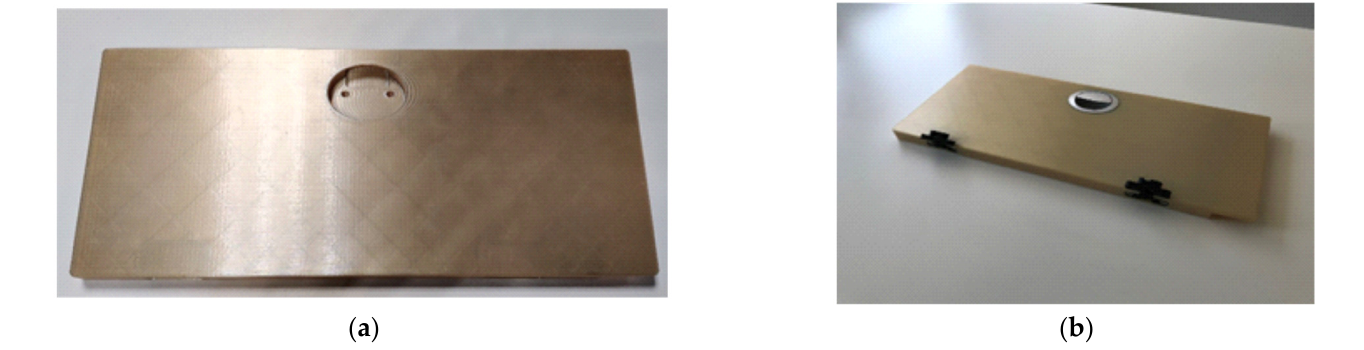
Figure 12. 3D-printed folding table from Ultem 9085 material ( a ), and the folding table assembled with mounting points ( b ).